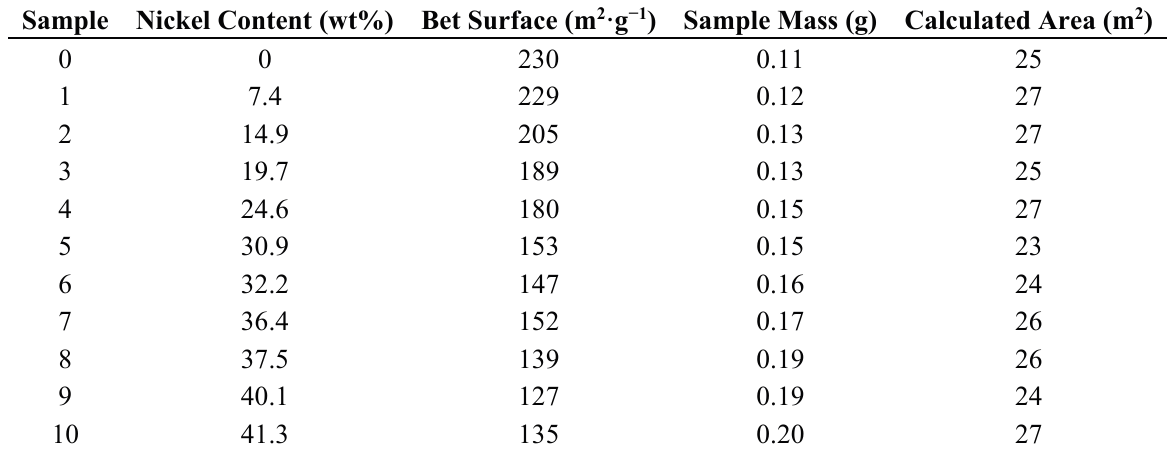
Table 2. Data from the self-prepared catalyst with different nickel contents on an Al 2 O 3 carrier